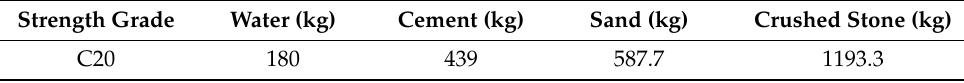
Table 2. The properties of steel bar, steel plate, and Carbon-Fiber-Reinforced Plastic (CFRP).